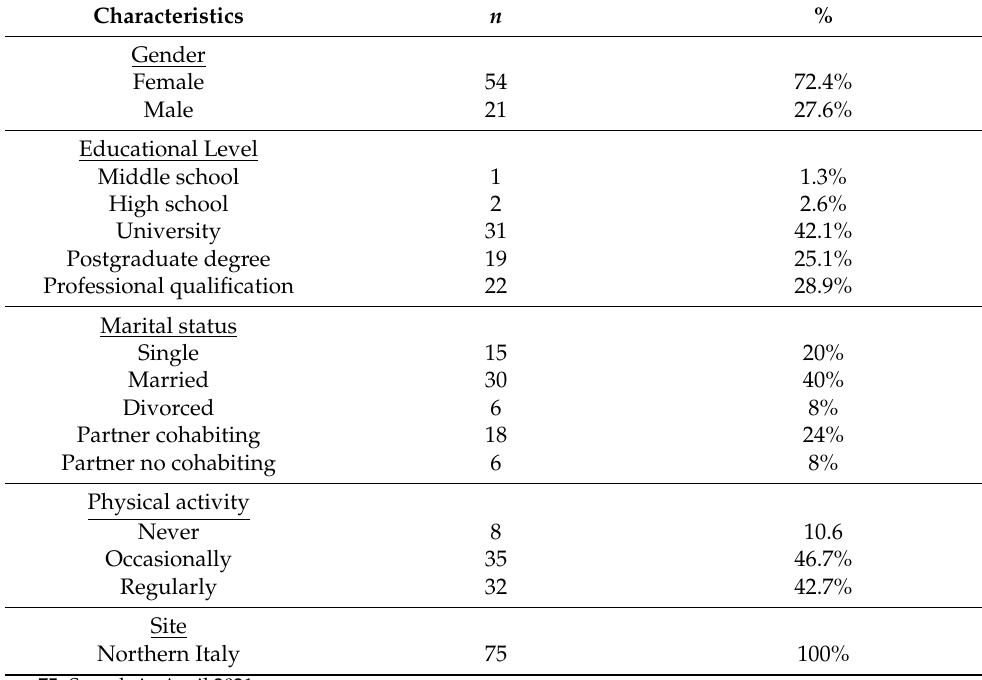
Table 1. Respondent profile: socio-demographic